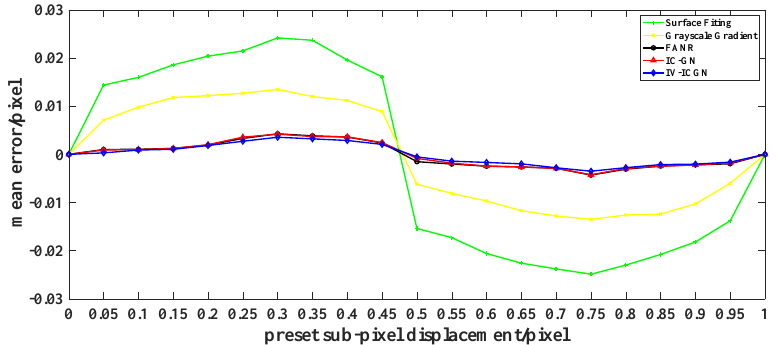
Figure 7. Comparison curve of the mean error in the u direction of five algorithms.